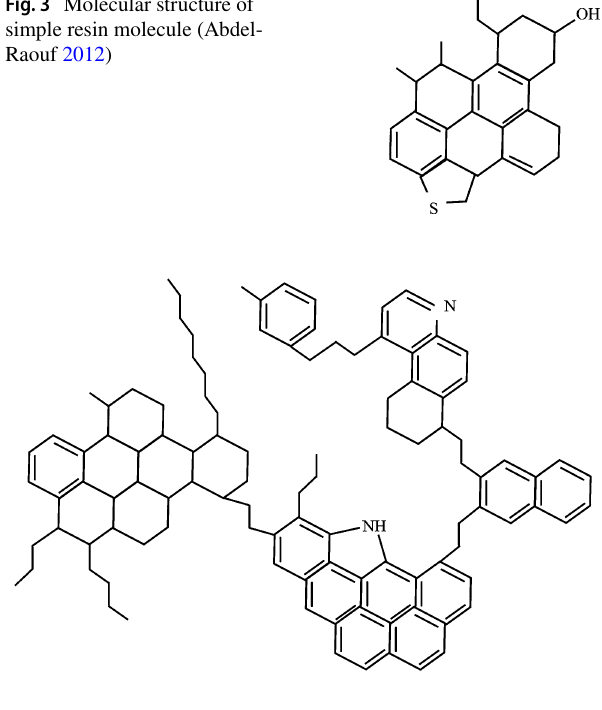
Fig. 4 Molecular structure of an asphaltene (Groenzin and Mullins